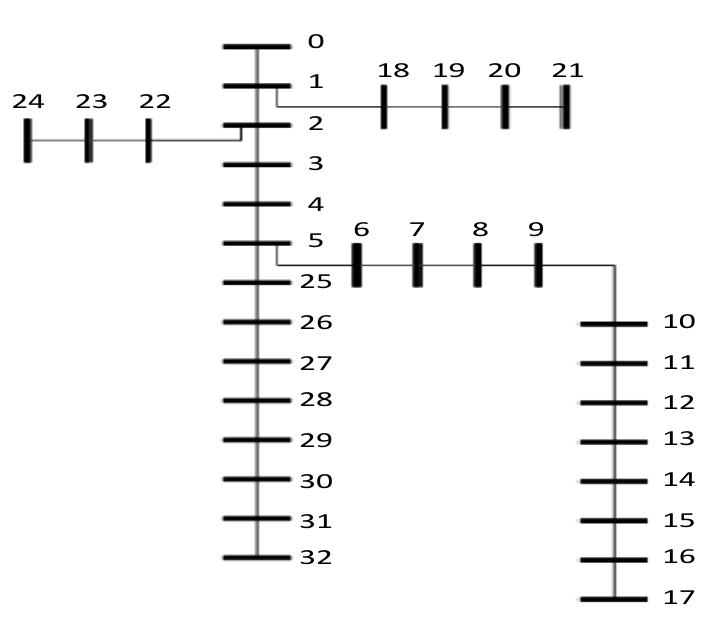
Figure 2. The 32-bus distribution